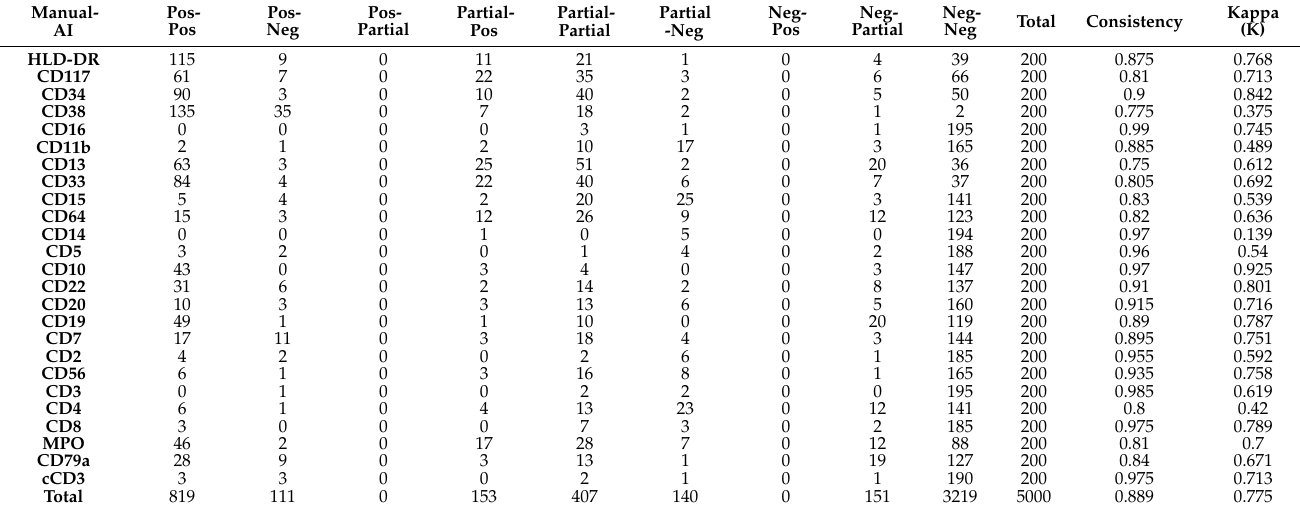
Table 2. Comparison of AI cell phenotypic diagnosis and artificial